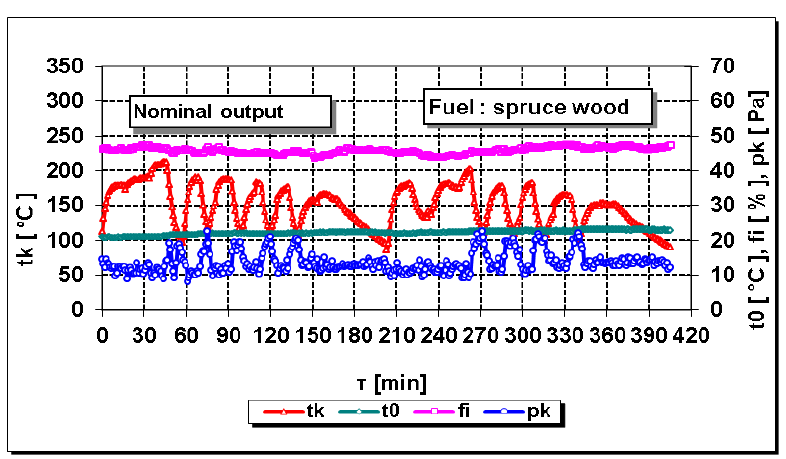
Figure 9. Course of measured variables for hot water boiler MAGA 23 where: tk—stack temperature (°C), t0—room temperature (°C), fi—relative humidity (°C), pk—stack draught (Pa). ( ◦ C), t0—room temperature ( ◦ C), fi—relative humidity ( ◦ C), pk—stack draught